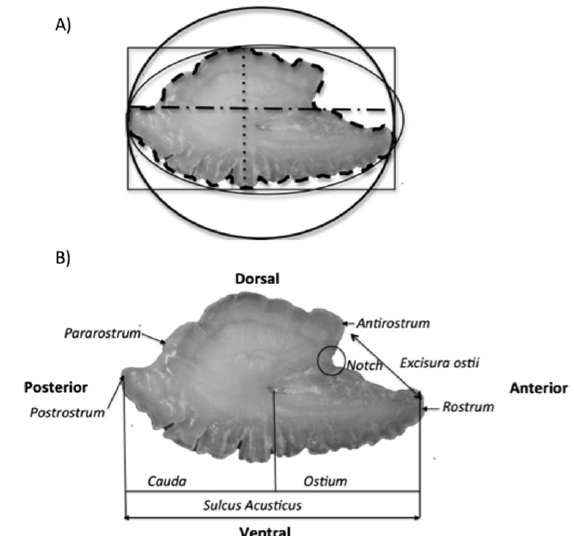
Fig . 2. – Otolith of Strangomera bentincki , showing: A) the main measurements, such as length (- × -) and breadth ( ××× ), perimeter (- - -), and areas of circle, ellipse, and rectangle covering the major and minor axis of otolith; and B) morphological description of the sagittal otolith.